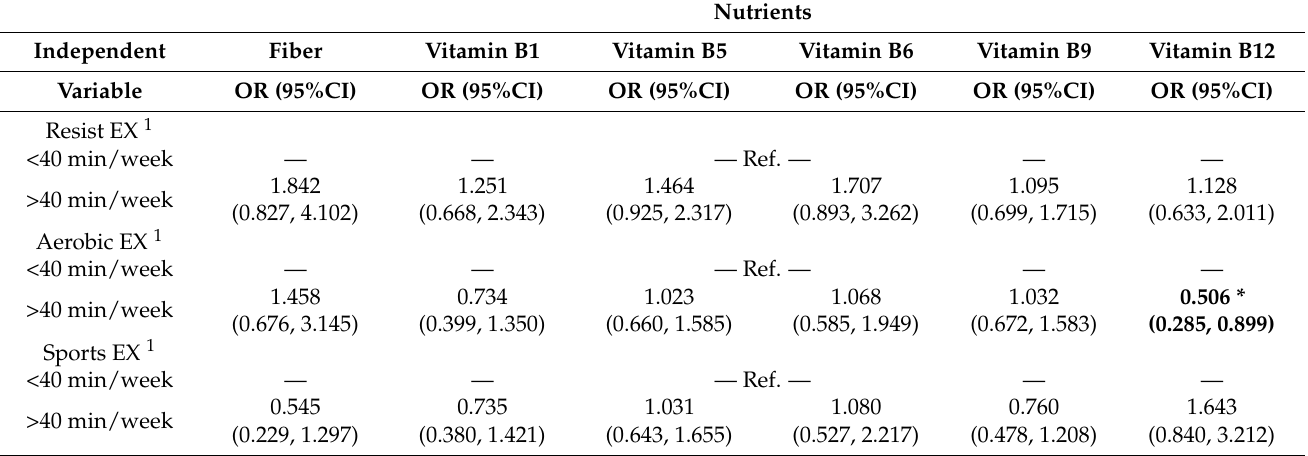
Table 5. Odds ratios of achieving DRI for nutrient intake in the study participants.